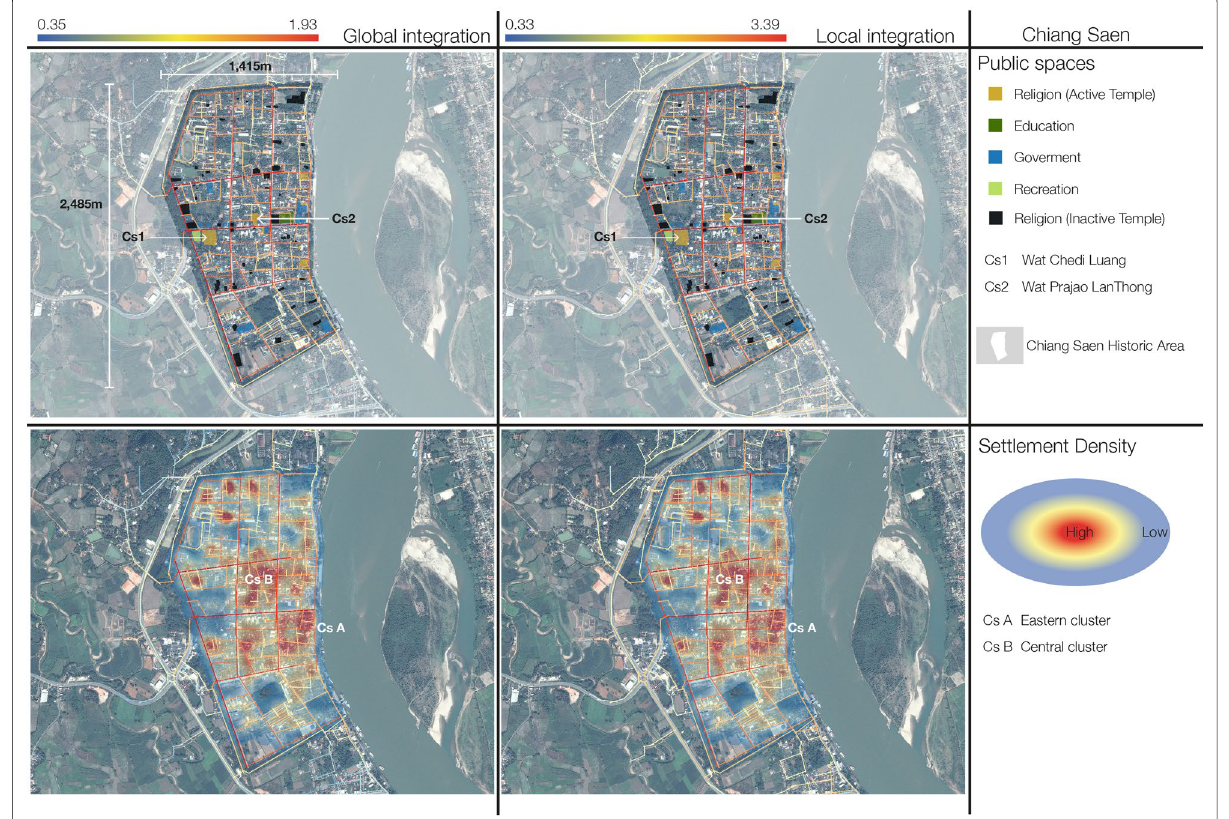
Fig. 8 Analysis of Chiang Saen’s spatial